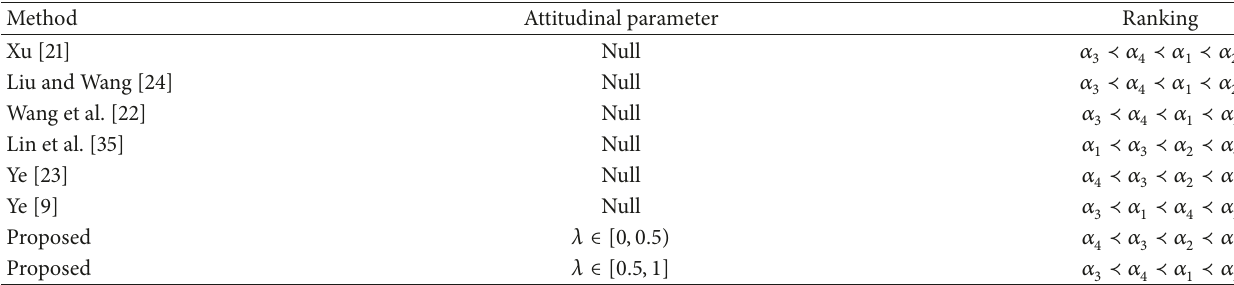
Table 2: Comparative results of different methods.